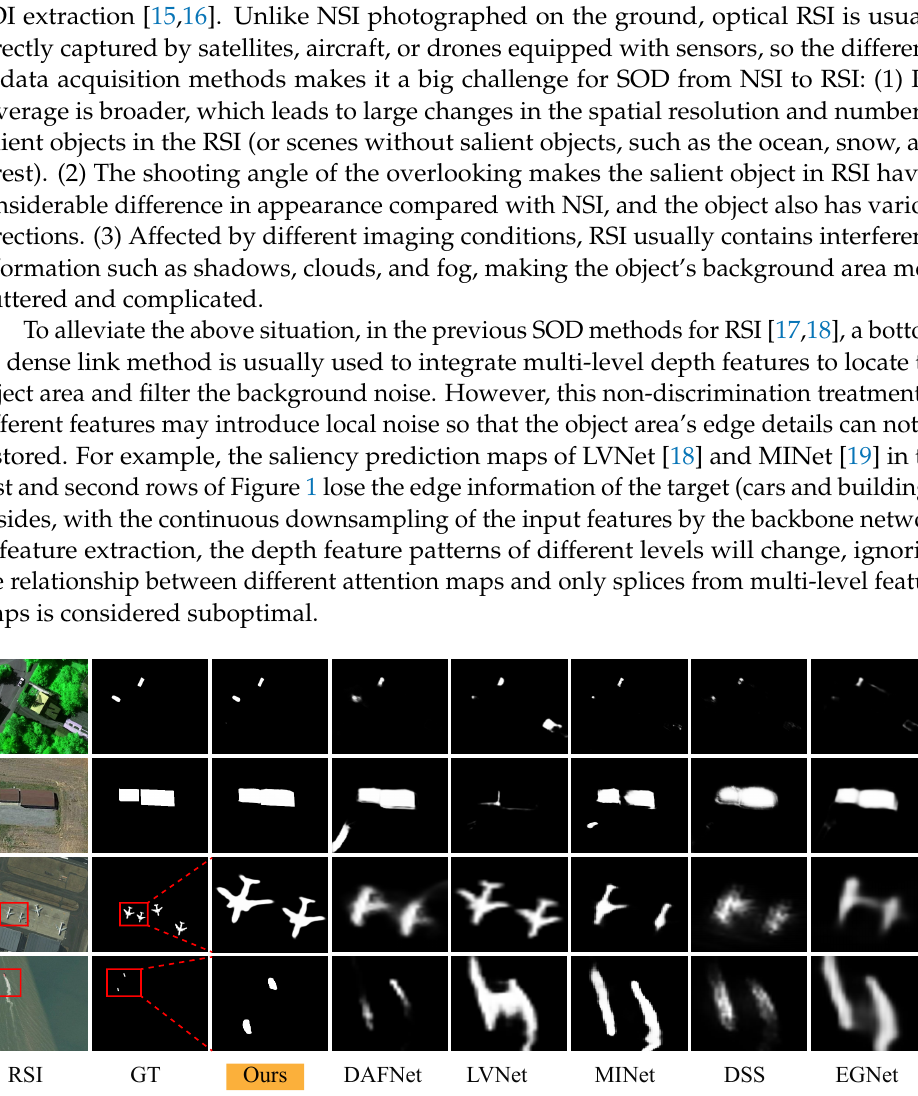
Figure 1. Visual examples of our model and DAFNet [20], LVNet [18], MINet [19], DSS [21] and EGNet DSS [22]. GT refers to the ground-truth